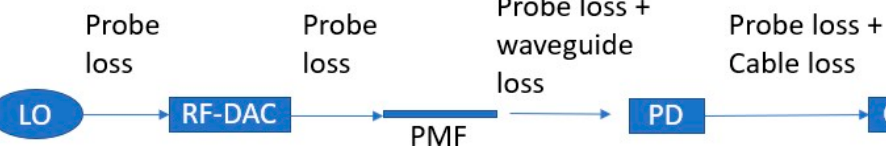
Figure 19. Overview of the link. Table 1. Link budget: carrier frequency at 131 GHz.